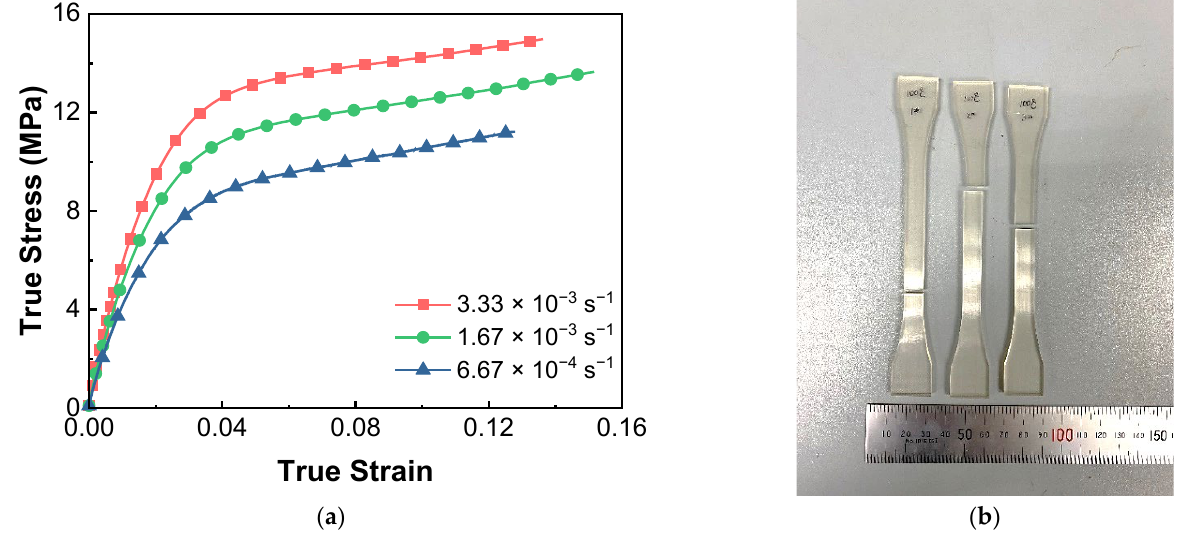
Figure 5. The uniaxial tensile test results of the metallized acrylic containing 5 wt % Gd(MAA) 3 and 30 wt % Pb(MAA) 2 at 100 °C. ( a ) The true stress–strain curves under different strain rates. ( b ) The fractured metallized acrylic specimens after tensile test at 100 °C.